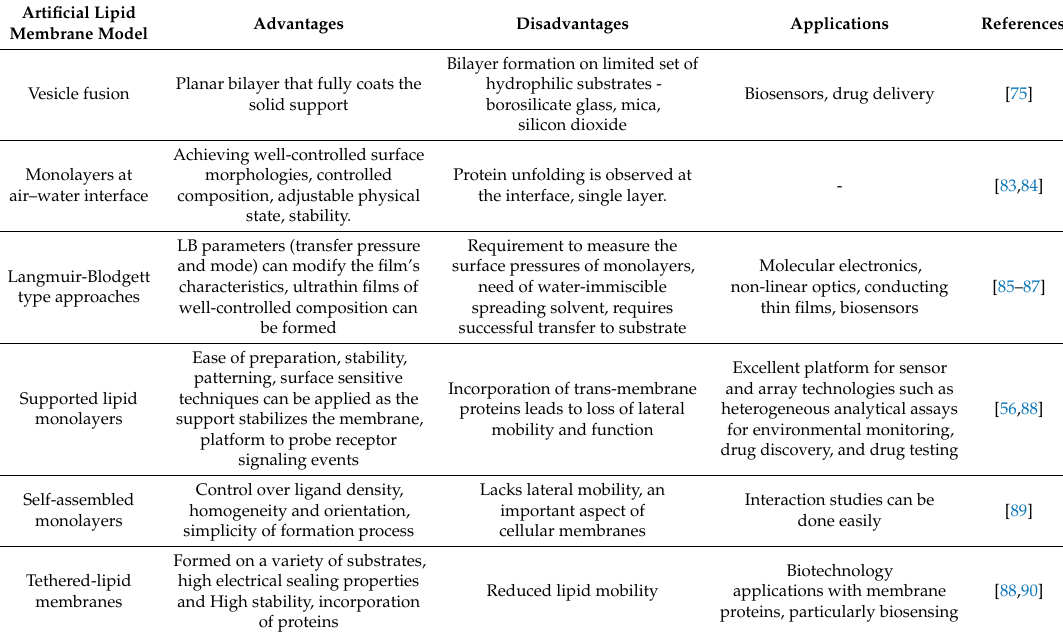
Table 1. Summary of selected artificial lipid membrane fabrication techniques and some of the advantages and disadvantages associated with each